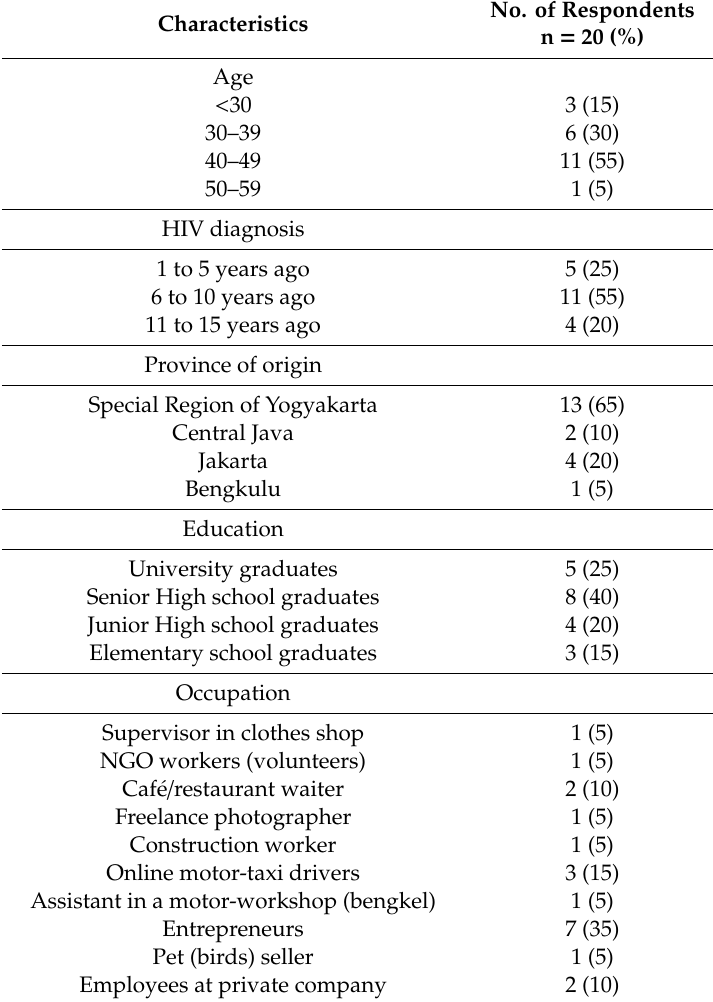
Table 1. Socio-demographic characteristic of the